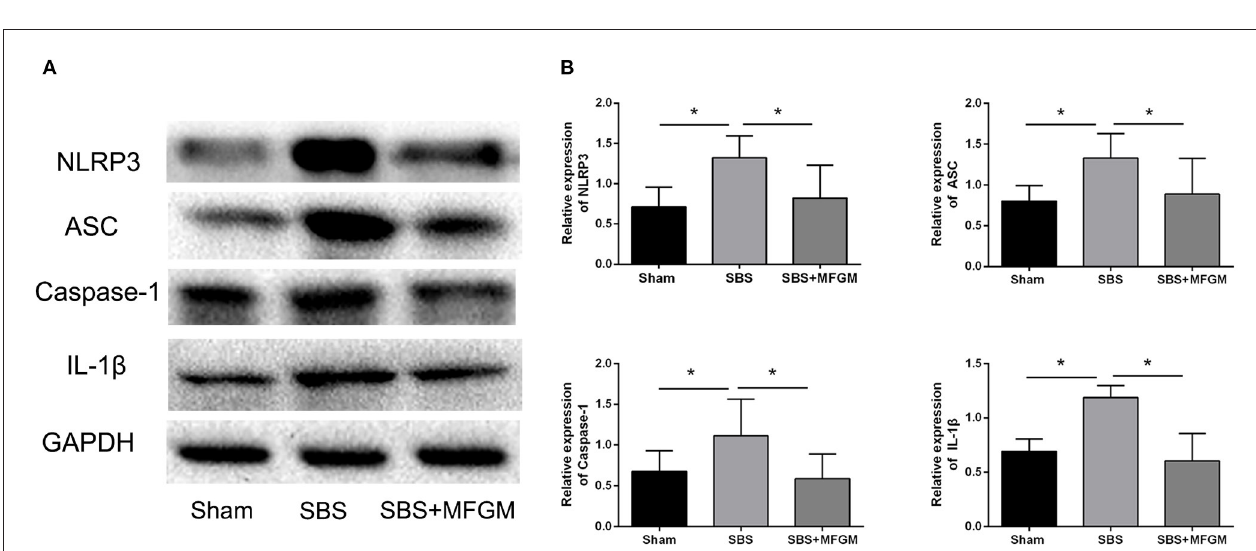
FIGURE 3 | Western blotting of the NLRP3-ASC-Caspase-1 pathway proteins in the liver (A) ; the relative expression of NLRP3 inflammasome proteins in the liver (B) . Data were presented as the means ± SD ( n = 5-7), group differences were determined by ANOVA test followed by Tukey’s post hoc test, and * P < 0.05 indicates a difference between the two groups. ASC, apoptosis-associated speck-like protein containing a CARD; Caspase-1, cysteinyl aspartate-specific protease-1; IL, interleukin; MFGM, milk fat globule membrane; NLRP3, nucleotide-binding oligomerization domain leucine-rich repeat and pyrin domain-containing protein 3; SBS, short bowel